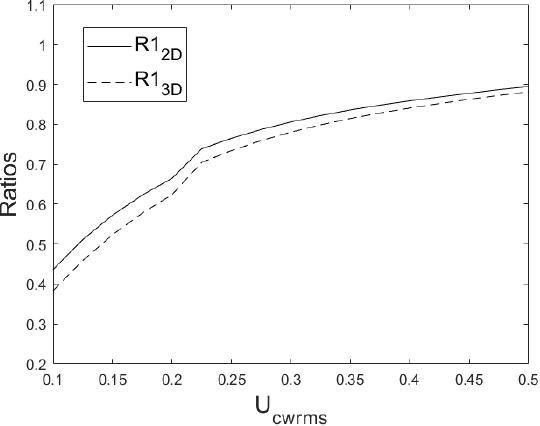
Figure 2. Nonlinear to linear ratio for 2D, R1 2D , waves and 3D, R1 3D , waves versus U cwrms .